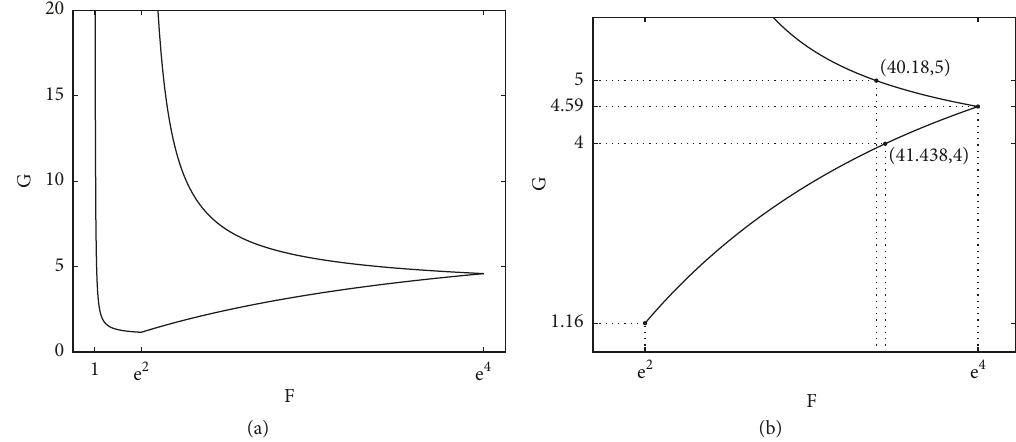
Figure 1: (a) Stability regions for equilibria: 𝐹 ∈ ⟨0,1⟩ : (𝑥, 𝑦) = (0, 0) is stable for any 𝐺 . 𝐹 ∈ ⟨1,𝑒 2 ⟩ : (̃𝑥, ̃𝑦) = ( ln 𝐹,0) is stable under the curve 𝐺 = 𝐹(𝐹 − 1) −1 . 𝐹 ∈ ⟨𝑒 2 ,𝑒 4 ⟩ : (𝑥 ∗ , 𝑦 ∗ ) = ( ln (𝐹 + 𝐺)𝐺 −1 , ln 𝐹𝐺(𝐹 + 𝐺) −1 ) is stable between the curves. (b) The points (𝐹,𝐺) = (41.438,4) and (𝐹,𝐺) = (40.18,5) in parameter space are located on the flip and Neimark-Sacker bifurcation curve,